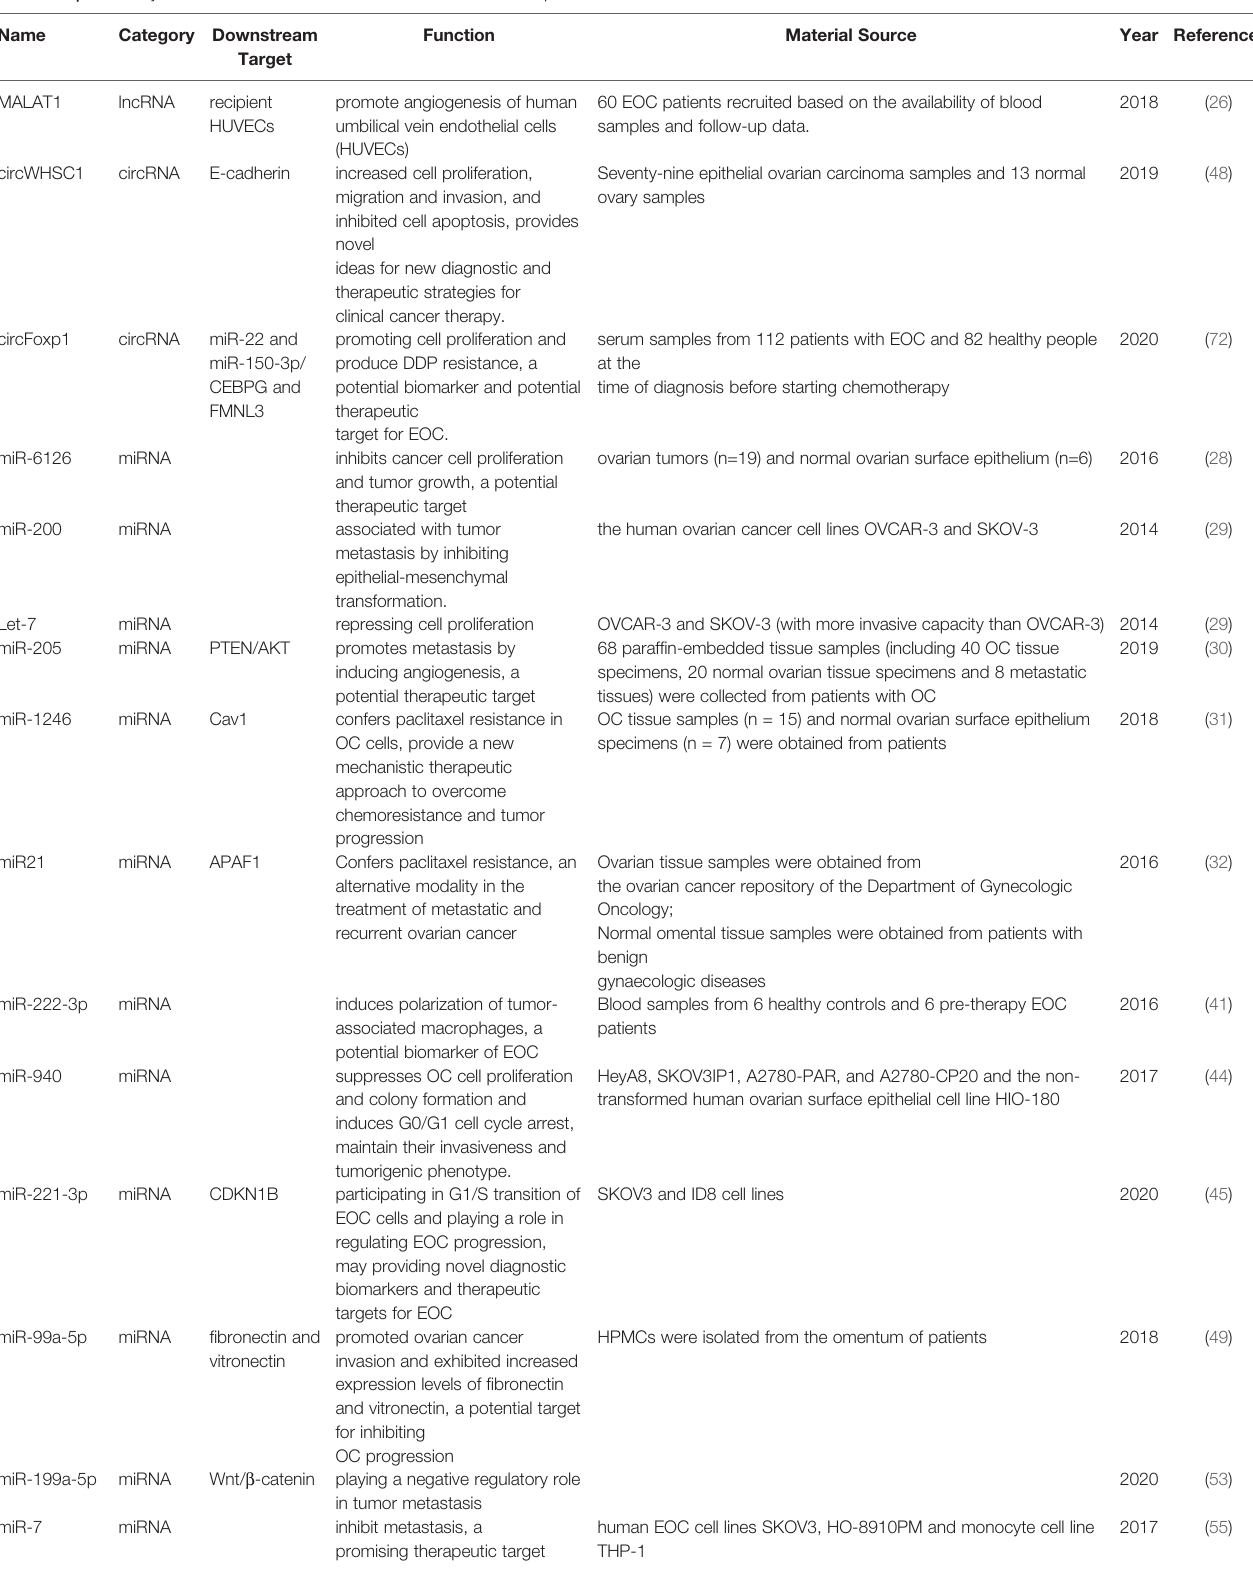
TABLE 1 | Summary of exosomal ncRNAs in the occurrence and development of OC.